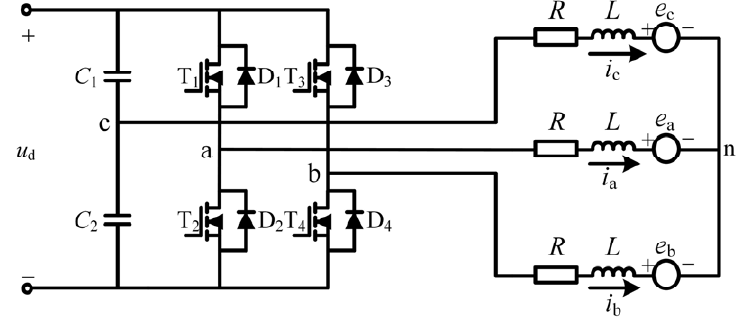
Figure 1. BLDCM is driven by FSTPI equivalent circuit.